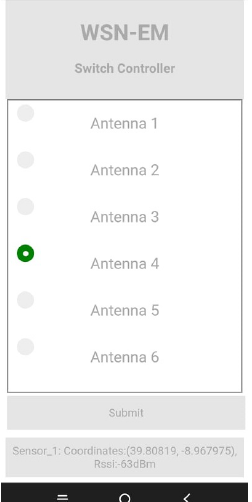
Figure 12. Screenshot of the user